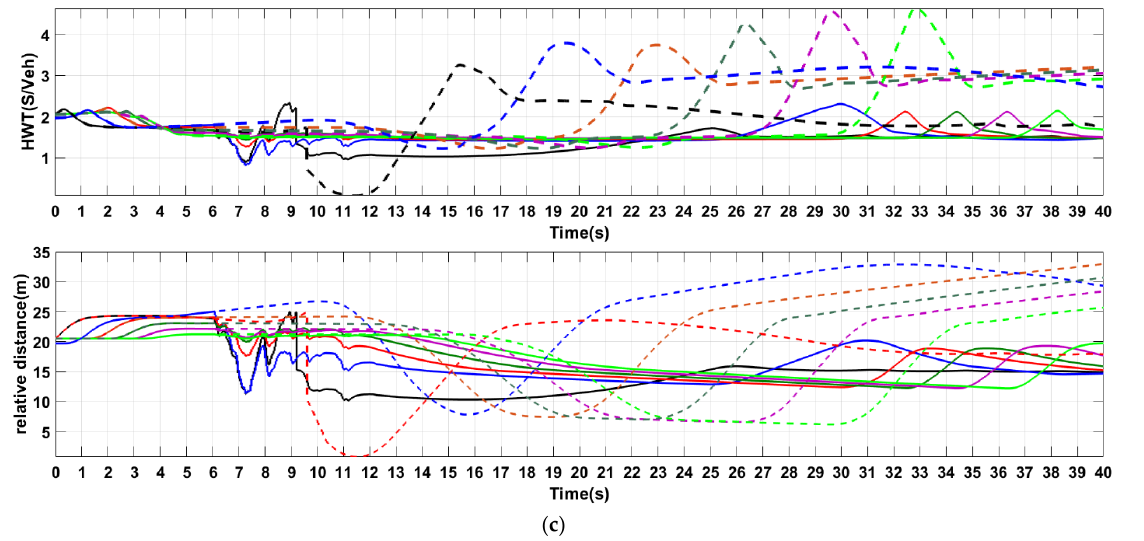
Figure 8. Simulation curve of CAVF fleet and CACCNF fleet in scenario 1: ( a ) CAVF fleet — HWT following distance speed; ( b ) CACCNF fleet — HWT following distance speed; ( c ) comparison of follow-up distance and HWT between CANF team and CACCNF team.